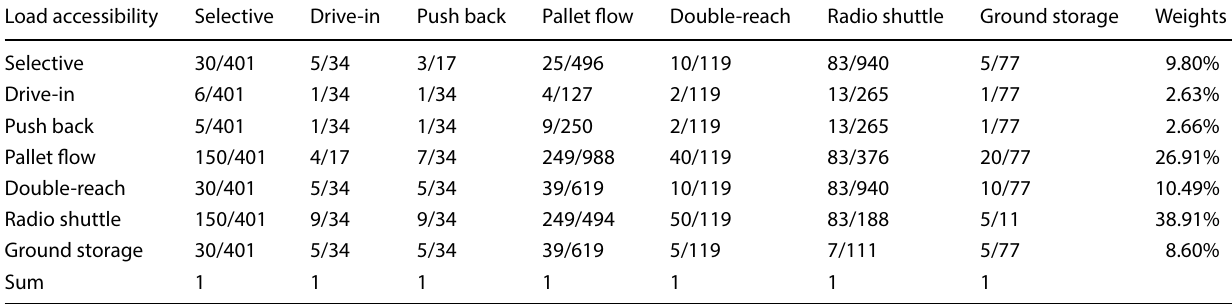
Table 13 Normalized matrix for the load accessibility criterion Load accessibility